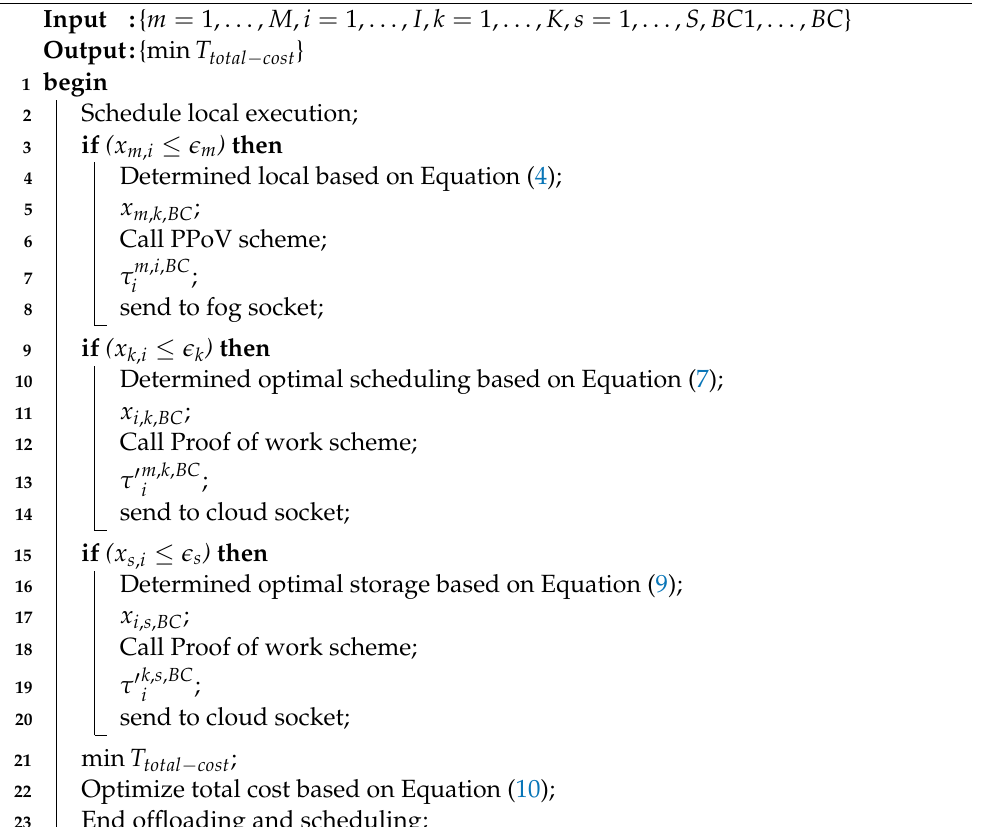
Algorithm 3 Optimal cost mobile-fog-cloud offloading and scheduling